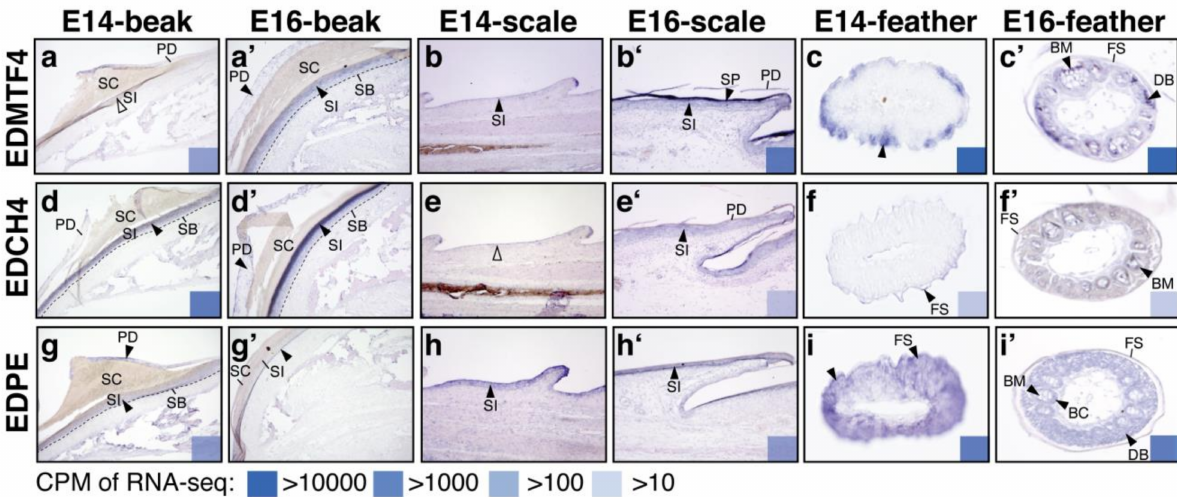
Figure 4. Expression patterns of selected non- β -keratin EDCs in developing beaks, scales, and feathers were analyzed by section in situ hybridization. Beaks and scales, sagittal sections. Feathers, cross sections. ( a – c , a’ – c’ ) In situ hybridization of EDMTF4 probes at E14 and E16, respectively; ( d – f , d’ – f’ ) In situ hybridization of EDCH4 probes at E14 and E16, respectively; ( g – i , g’ – i’ ) In situ hybridization of EDPE probes at E14 and E16, respectively. Filled arrowheads indicate the location of in situ hybridization signals. The expression levels (CPM, counts per million mapped reads) of each gene from RNA-seq data are indicated in the bottom right. Abbreviations: BC, barb cortex; BM, barb medulla; DB, downy barbules; FS, feather sheath; PD, periderm; SB, stratum basal; SC, stratum corneum; SI, stratum intermedium; SP,